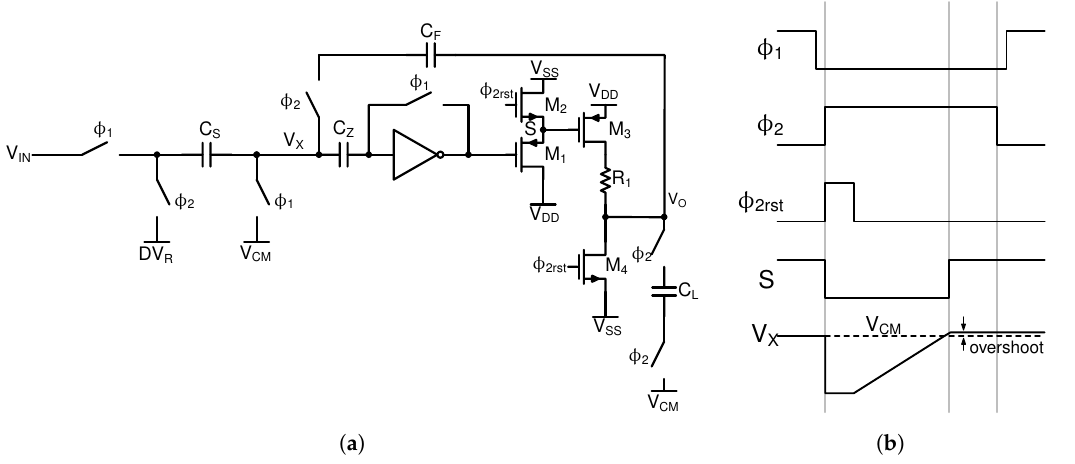
Figure 4. The inverter-based zero-crossing-based integrators (ZCBI) using a dynamic buffer. ( a ) Schematic diagram. ( b ) Timing diagram.